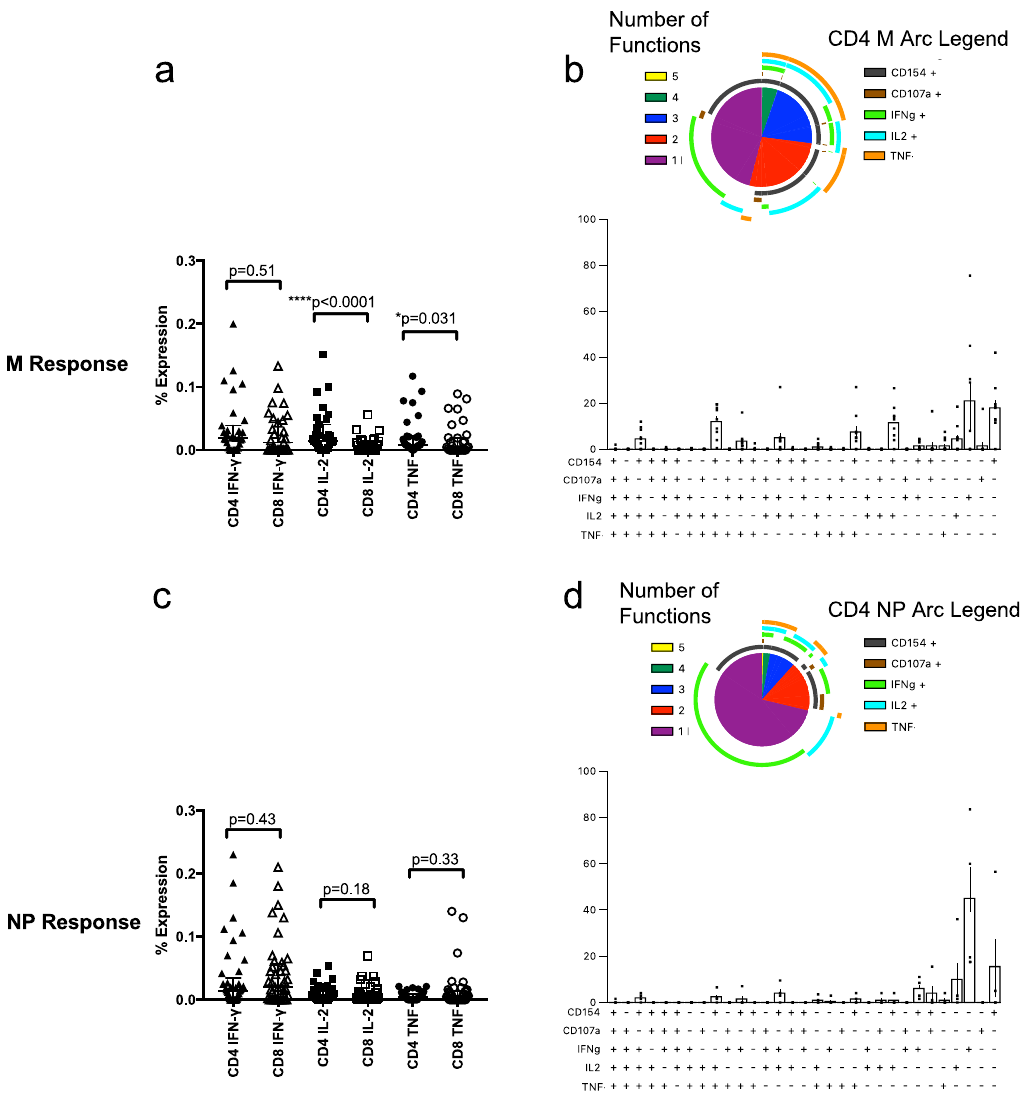
Fig. 4 ICS responses in CD4 + and CD8 + T cells for M and NP pools in ELISpot positive individuals. ICS was performed on individuals with convalescent mild cases and a positive ELISpot for the indicated peptides. PBMC were stimulated with 2 μ g/ml peptide for 6 h. Expression levels of IFN- γ , IL-2 and TNF in CD4 + and CD8 + T cells using M pools are shown in a , n = 31. Bars represent median ± IQR. Statistics were performed using a two-tailed Wilcoxon matched-pairs signed-rank test between each cytokine in CD4 + vs CD8 + T cells. Boolean gates were then set and cytokine expression was examined in CD4 + T cells ( n = 9) using SPICE ( b ). Error bars represent SEM for cytokine expression fi gures. Expression levels of cytokines using NP pools are shown in c ( n = 41) with polyfunctionality analysis for CD4 + T cells ( d ) ( n = 4) as